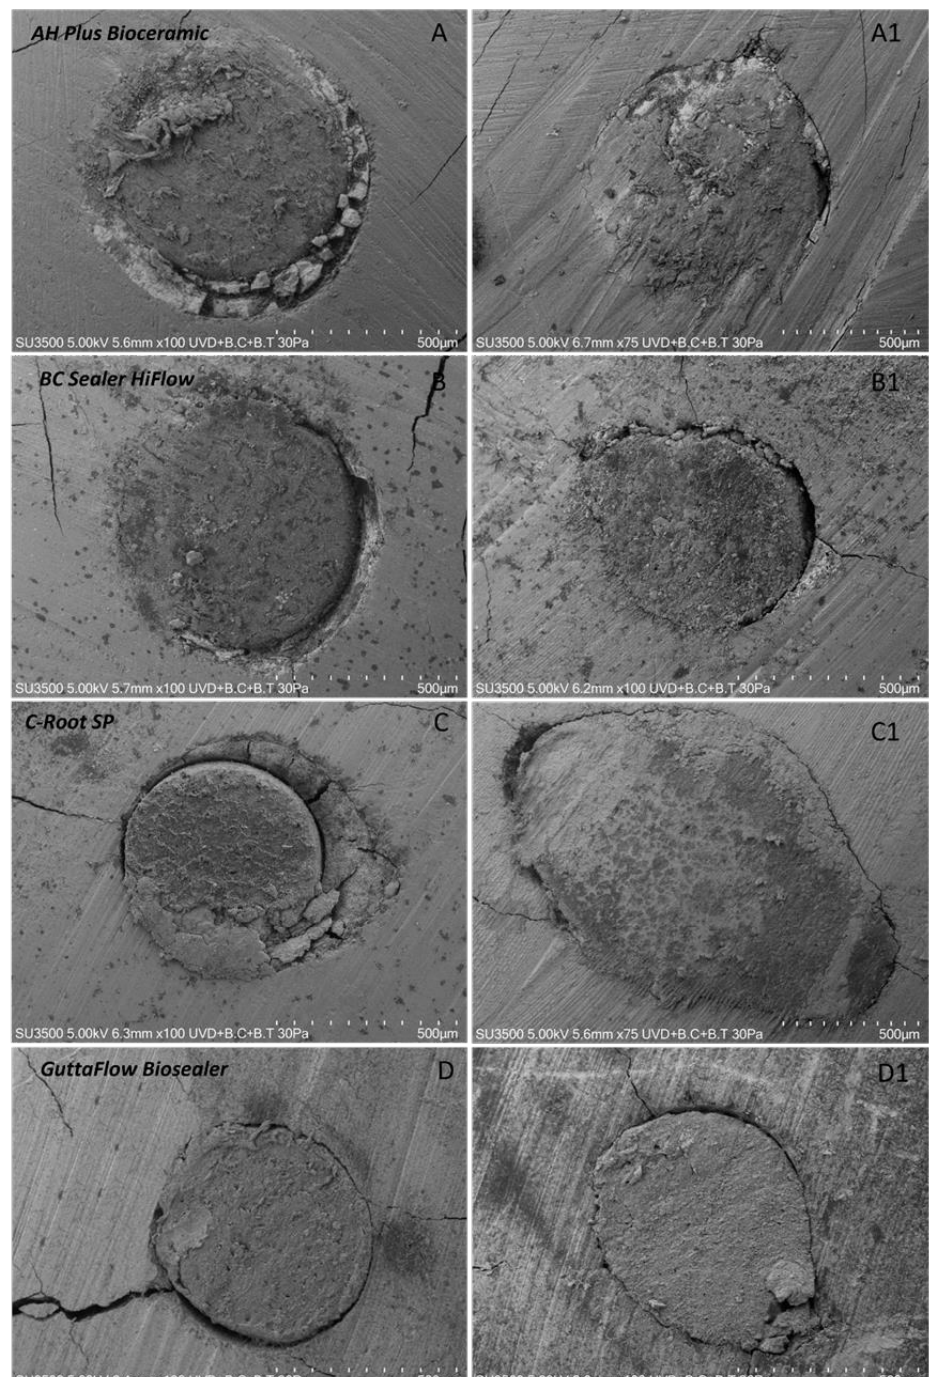
Figure 5. SEM micrographs showing the coronal sections of the root canal obturated according to the selected sealer (described in the left column) and the obturation technique used (left column shows single-cone technique, right column shows thermomechanical compaction). ( A ) AH Plus Bioceramic used with SC technique; ( A1 ) AH Plus Bioceramic used with TC technique; ( B ) BC Sealer HiFlow used with SC technique; ( B1 ) BC Sealer HiFlow used with TC technique; ( C ) C-Root SP used with SC technique; ( C1 ) C-Root SP used with TC technique; ( D ) GuttaFlow Biosealer used with SC technique; ( D1 ) GuttaFlow Biosealer used with TC